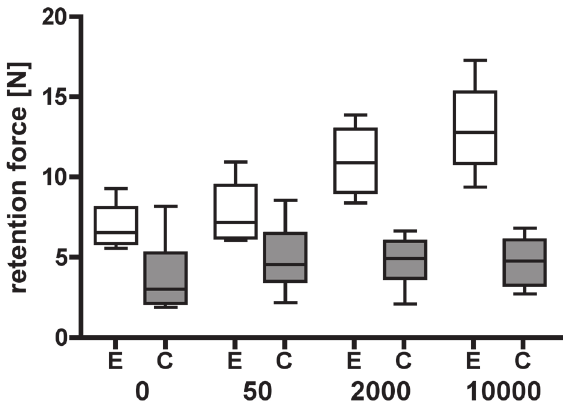
Figure 5- Force distance integrals calculated at the 4 particular points in time (cycle 0; 50; 2,000; 10,000) for group E (electroplated female part) and group C (cast female part)